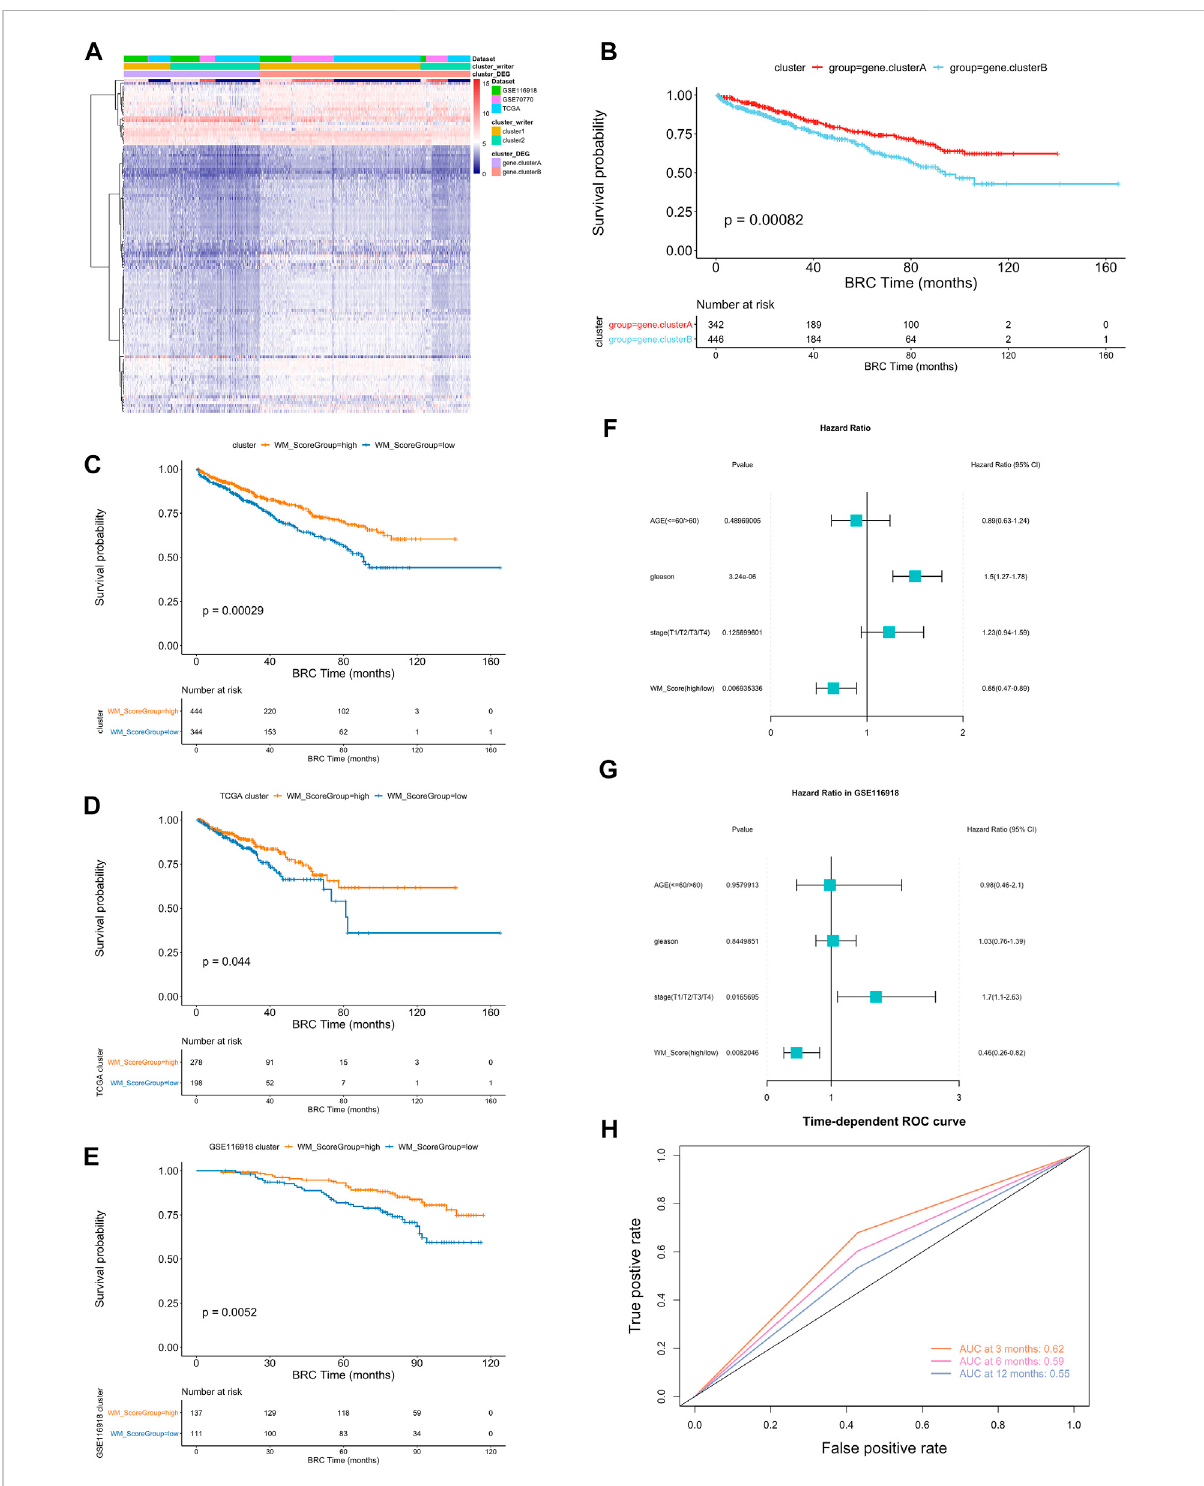
FIGURE 3 (A) Unsupervised clustering of the RNA modi fi cation phenotype-related genes. The names of those 3 PC cohorts were used as sample annotations. Red, high expression of phenotype-related genes; blue, low expression. (B) Kaplan-Meier curves comparing overall survival between twoDEG clusters,gene. cluster_A(red) andgene. cluster_B (blue), inthe3 PCcohort.The grouping ofPCsamplesisshownundertheKaplan-Meier plot. P < 0.05 in the two-sided log-rank test was considered statistically signi fi cant. (C – E) Kaplan-Meier curves show overall survival in WM_ Score-high (red)and-low (blue)inall samples (C) ,TCGA (D) andGSE116918 (E) .Thegrouping ofPCsamplesisshownatthebottomofthechart. P <